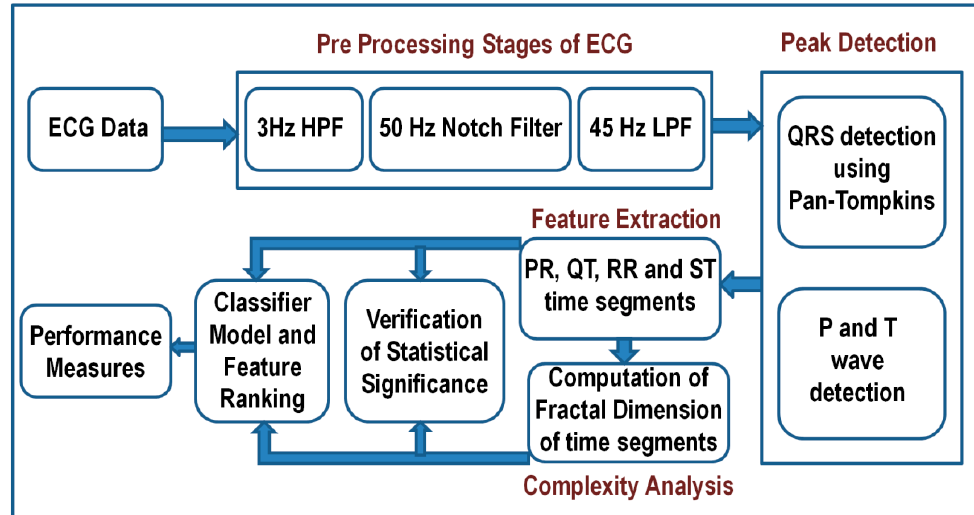
Figure 1. Schematic block diagram.